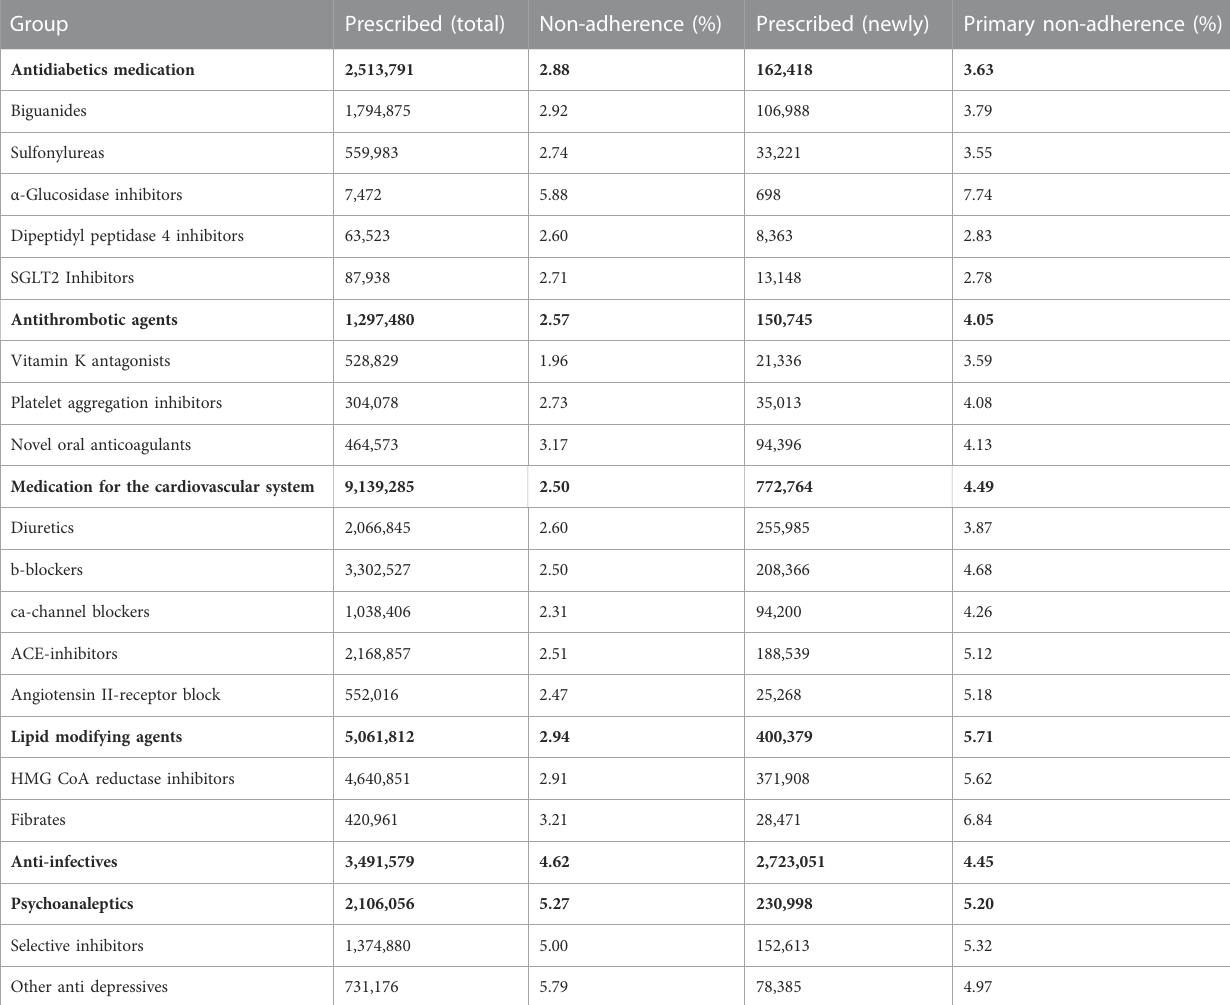
TABLE 4 Issued and collected electronic prescriptions in the studied sample — non-adherence and primary non-adherence in the main groups and subgroups of studied substances.